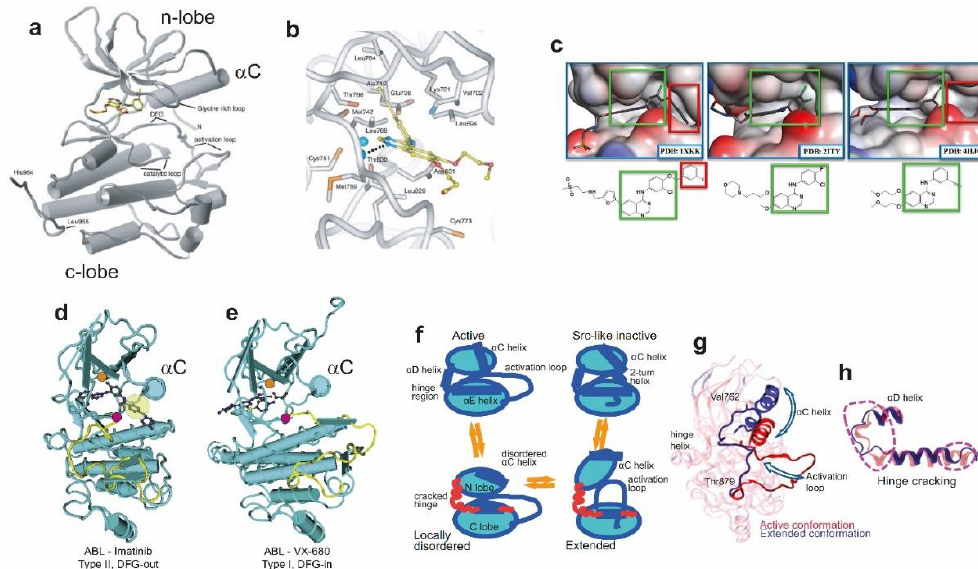
Figure 2. Structure and dynamics of the kinase domain. ( a ) Structure of the EGFR kinase domain with the inhibitor erlotinib bound in the cleft between the amino-terminal and carboxy-terminal lobes (PDB: 1M14). Taken, with permission, from Stamos et al. [120]. ( b ) The inhibitor binding site and nearby residues from the EGFR kinase domain complexed with erlotinib. The dashed line indicates an H-bond from the receptor to the drug, and a water molecule is shown as a pale blue sphere. Taken,